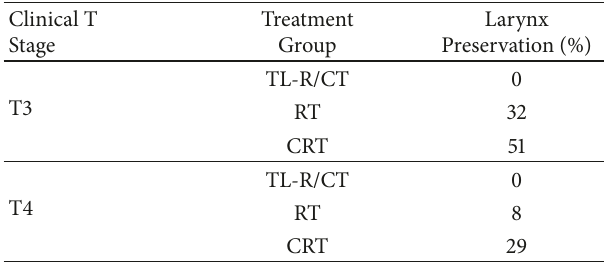
Table 3: Measures of disease control by clinical T-stage and treat- ment groups among patients diagnosed with laryngeal cancer, South of Iran,